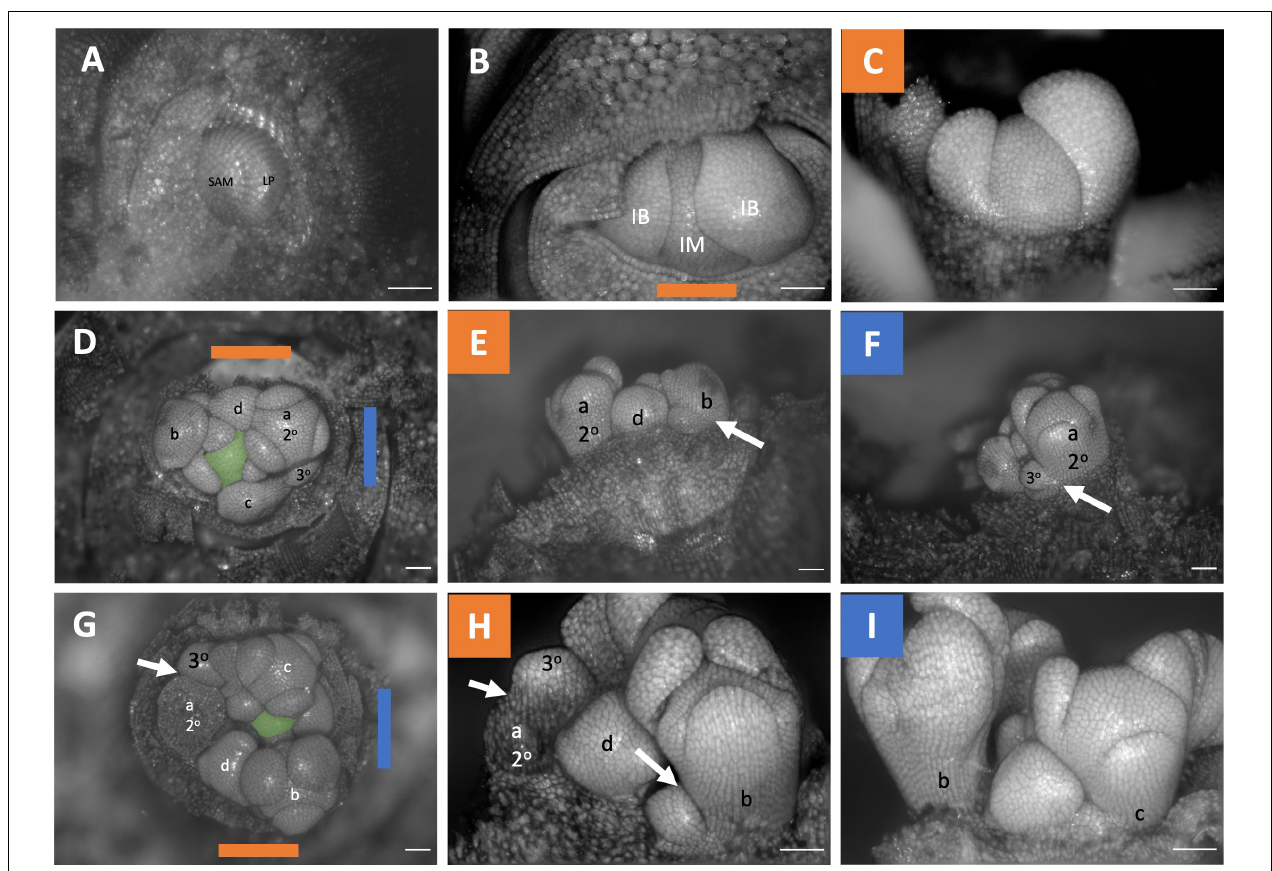
FIGURE 5 | Triteleia laxa inflorescence developmental morphology. (A) Shoot Apical Meristem. (B,C) Inflorescence meristem imaged from the apex (B) and laterally (C) . (D–I) Two stages of inflorescence development. ( D–I) Two series of inflorescence development. The meristems in the first column (D,G) are imaged from the apex and the second (E,H) and third (F,I) columns are imaged laterally. Colored lines on images taken from the apex (B,D,G) indicate orientation of the inflorescence in subsequent panels. The first 4 second-order flowers lettered a-d indicating sequence of initiation (D–I) . Branching order (2 ◦ , 3 ◦ ) labeled only for the cyme of the first flower initiated a. SAM, shoot apical meristem; LP, leaf primordia; IM, inflorescence meristem, false colored green (D,G) ; IB, Inflorescence bract. White arrows indicate branching events between second and third order branches. Scale bar of all images: 100 µ